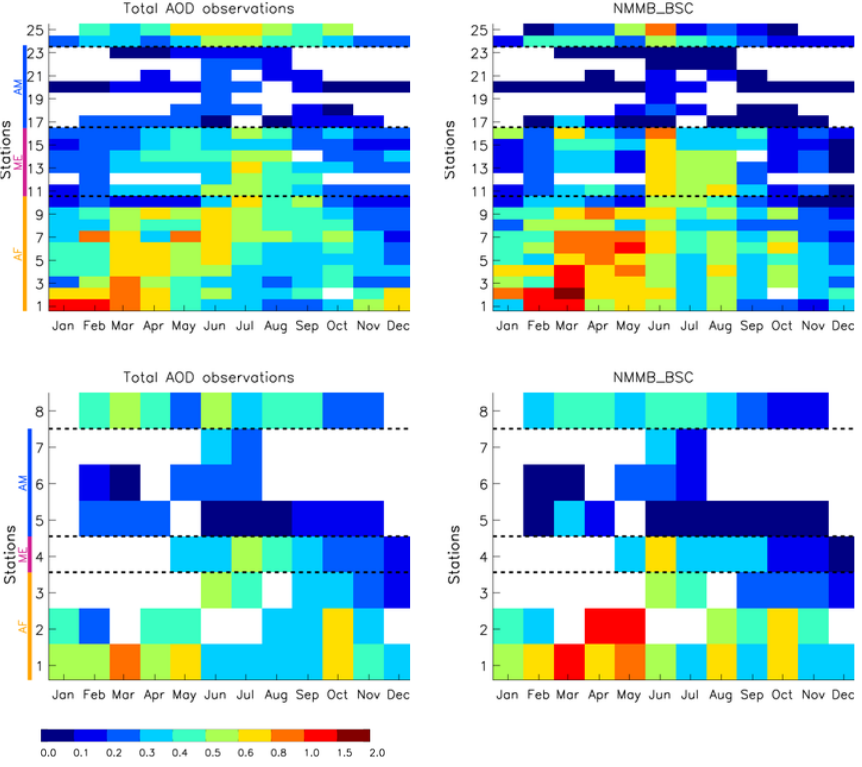
Fig. 13. Left panels are from AERONET observations and right panels are from model output. At the top, AOD at 550 nm at dusty stations for the climatology, and at the bottom AOD at 550 nm at dusty stations for year 2000. Each row corresponds to the seasonal cycle at one of the stations. They have been grouped into African (AF, orange), Middle East (ME, violet) and American (AM, blue) stations and stations elsewhere in the world (OT, black). Each one of these groups is identified by a colored bar on the left side of the left panels. Stations are ordered from south to north within each group. The row for each station corresponds to the numbers presented in Fig. 12. Name and location of each station are given in (Huneeus et al., 2011). White color corresponds to months without measurements or months not complying with the selection criteria. 66